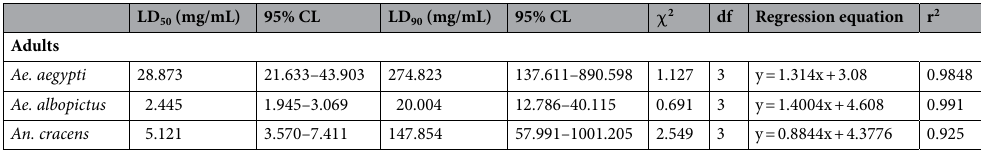
Table 3. Lethal doses of Streptomyces sp. KSF103 EA extract on the adults (24 h exposure) of Ae. aegypti , Ae. albopictus , and An. cracens (n = 1200). LD 50 lethal dose that kills 50% of the exposed organisms, LD 90 lethal dose that kills 90% of the exposed organisms, UCL upper confidence limit, LCL lower confidence limit, χ 2 Chi square, df degrees of freedom, r 2 regression co-efficient.